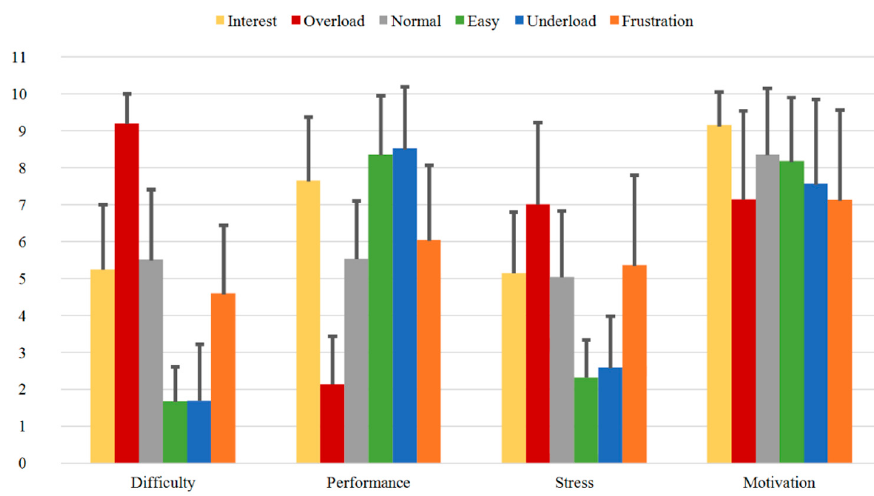
Figure 12. Direct Questions of Group A for all the sequences with mean values.